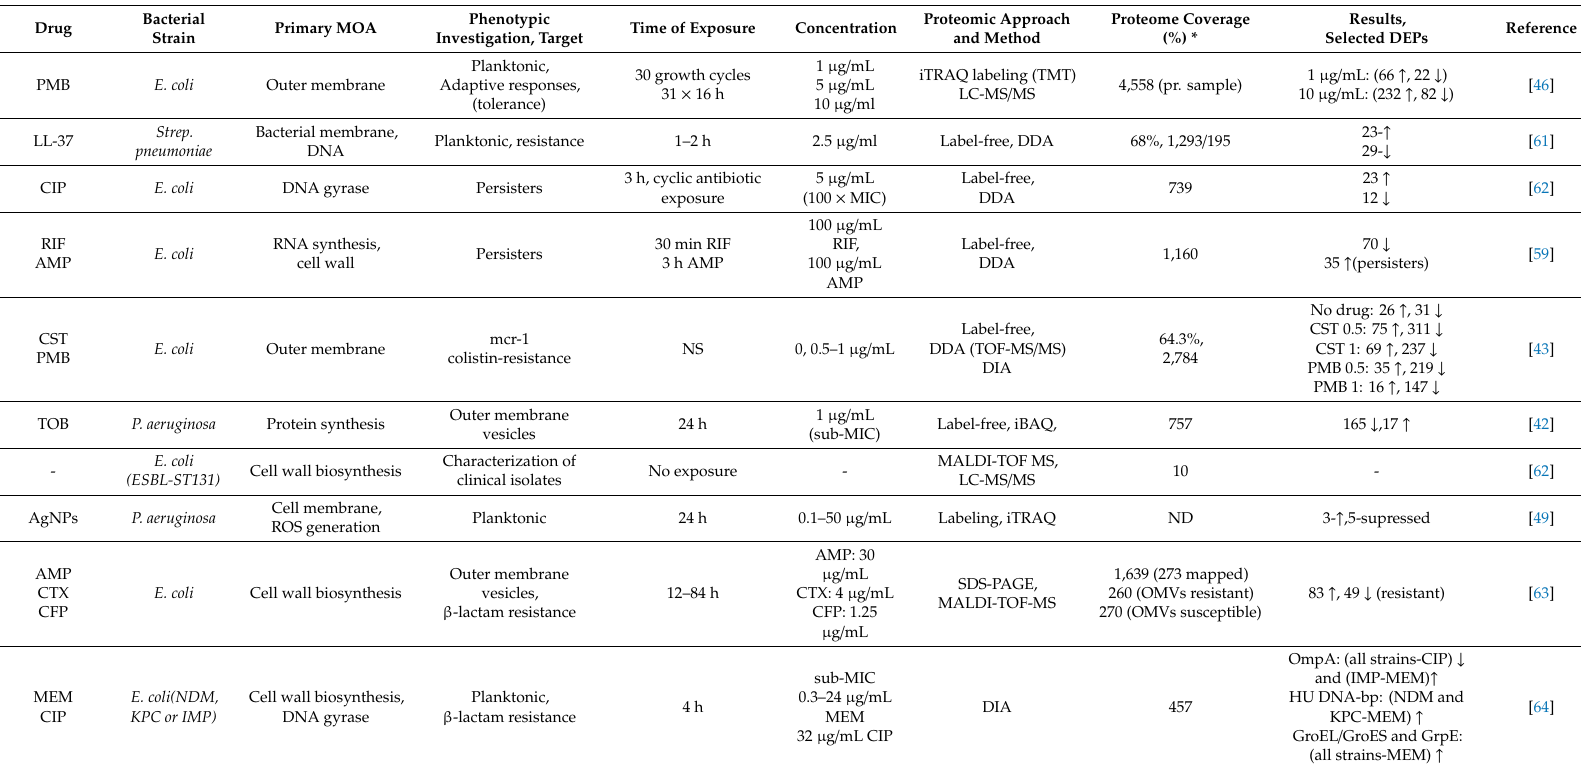
Table 2. Summary of selected literature, shown in descending order from 2020 to 2010, on proteomic analysis of antibiotic response in di ff erent